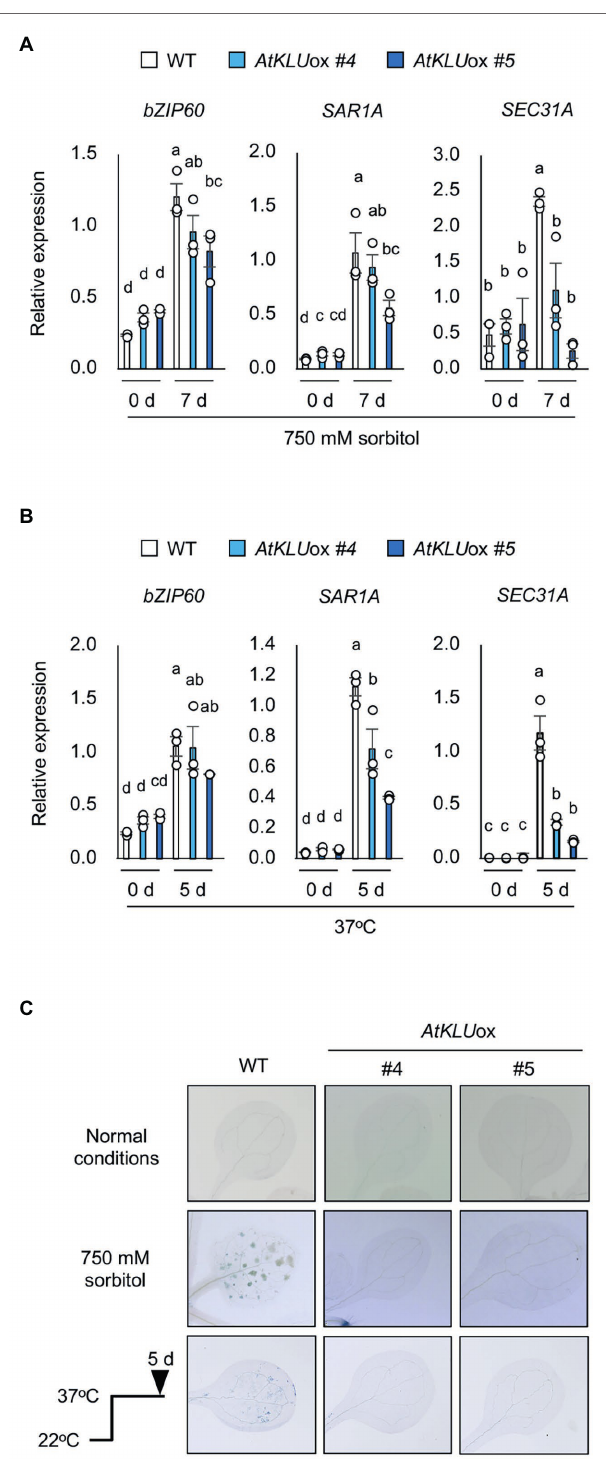
FIGURE 7 | ER stress in AtKLU ox plants under osmotic or heat stress. (A) Transcript levels of bZIP60 , SAR1A , and SEC31A in WT and AtKLU ox plants under normal (0 day) and osmotic stress condition (750 mM sorbitol for 7 days). (B) Transcript levels of bZIP60 , SAR1A , and SEC31A in WT and AtKLU ox plants under normal (0 day) and heat stress (37 ° C for 8 h) conditions. Expression levels were determined by quantitative real-time PCR relative